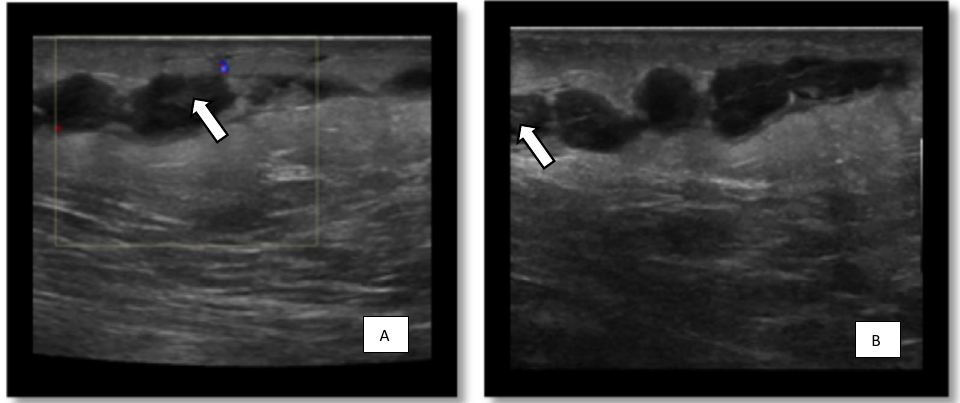
Fig. 1 A, B Ultrasound scan of the concerned palpable swelling in the right upper outer quadrant which revealed a beaded appearance of the superficial vein (right lateral thoracic vein) with intraluminal echogenicity within (arrow). The absence of internal colour Doppler flow was